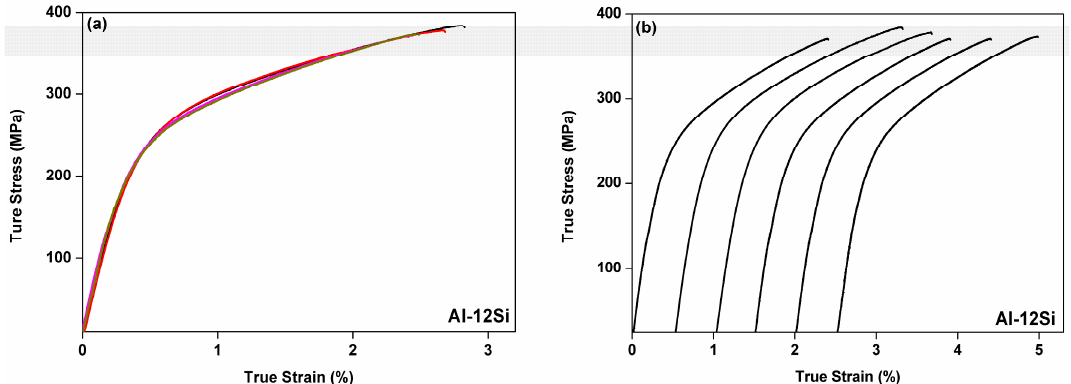
Figure 1. Room temperature tensile test curves for the Al-12Si SLM samples ( a ) consolidated data; ( b ) individual tensile curves. Table 1. Tensile properties of samples produced by selective laser melting (SLM) and casting (cast).